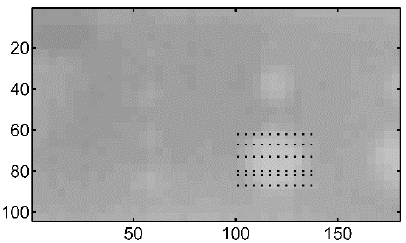
Figure 11. Segments of consecutive frames (broken lines) selected for intensity variation analysis.